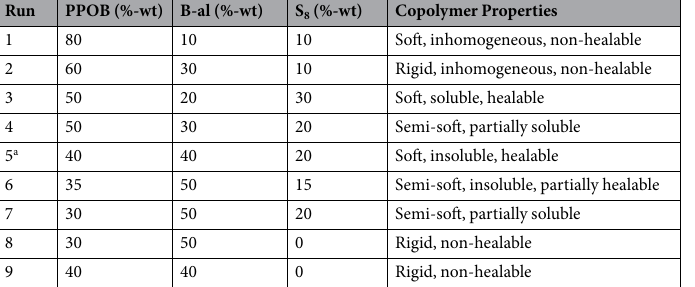
Table 1. DSC a characteristics of B-al, PPOB and PPOB 40 -B-al 40 -S 20 . a DSC thermograms were collected under 20 mL.min − 1 N